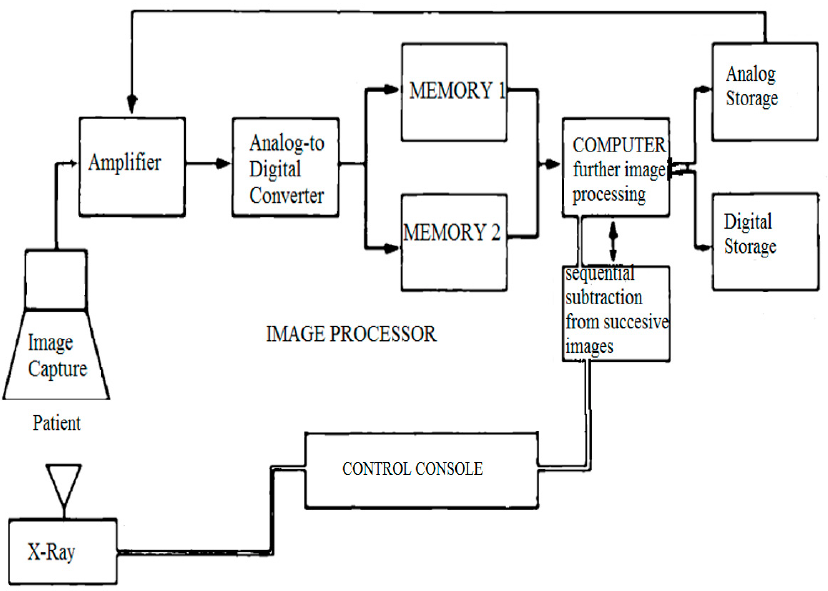
Figure 1. Flow of information in a generalized digital subtraction Figure 1 . Flow of information in a generalized digital subtraction system.